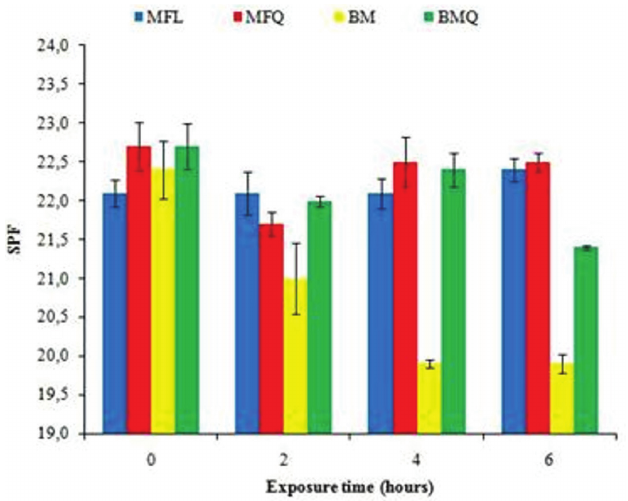
FIGURE 3 - In vitro Sun Protection Factor (SPF) of MFQ, MFL, BM and BMQ formulations, after six hours of sun exposure. The results were expressed as mean ± DP, with n = 3.0. Abbreviation: MFQ - formulation containing octyl-p-methoxycinnamate (OMC), benzophenone-3 (BP-3), ethylhexylmethoxycrylene (EHMCR) and keratin; MFL - formulation containing OMC, BP-3 and EHMCR; BM - formulation containing OMC and BP-3; BMQ - formulation containing OMC, BP-3 and